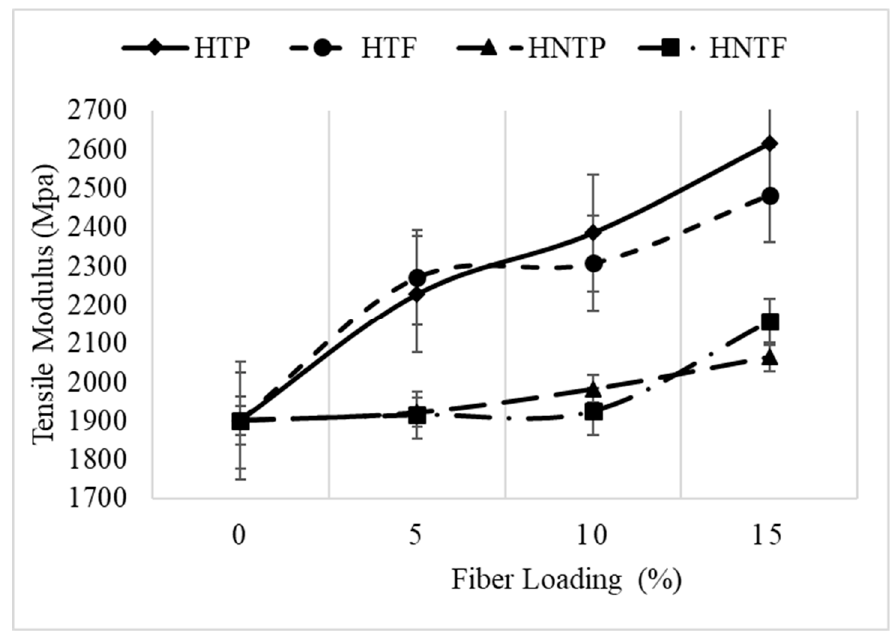
Figure 4. Effect of treatment and fiber loading on tensile modulus. Figure 4. E ff ect of treatment and fiber loading on tensile